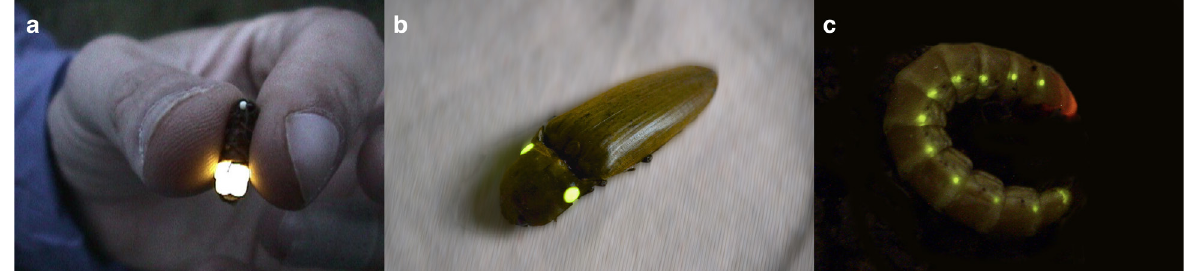
Figure 1 - Photographs of a firefly ( Macrolampis omissa ) ( a ), a click-beetle ( Pyrophorus sp.) ( b ), and a railroad-worm ( Phrixothrix hirtus ) ( c